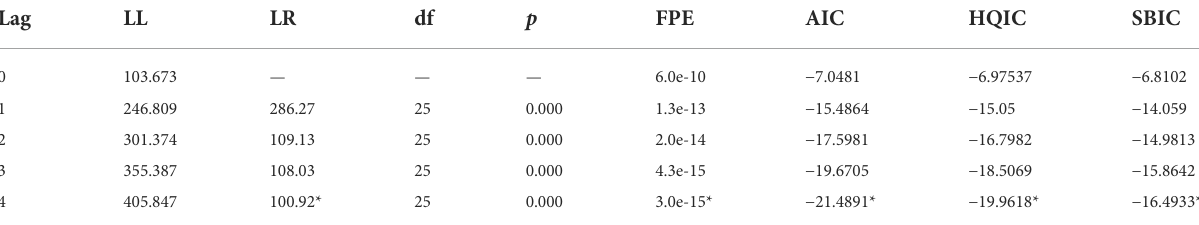
TABLE 4 Lag-order selection criteria.